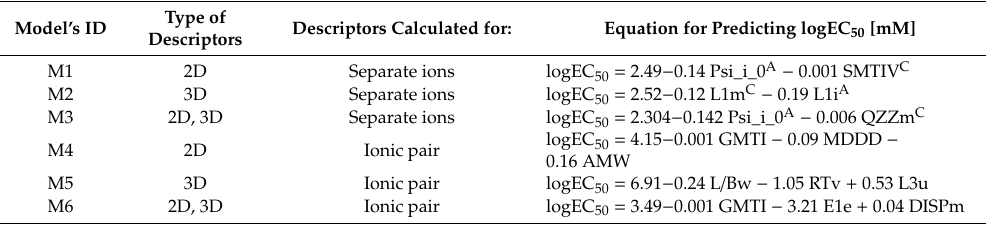
Table 1. The equations of all models developed in this